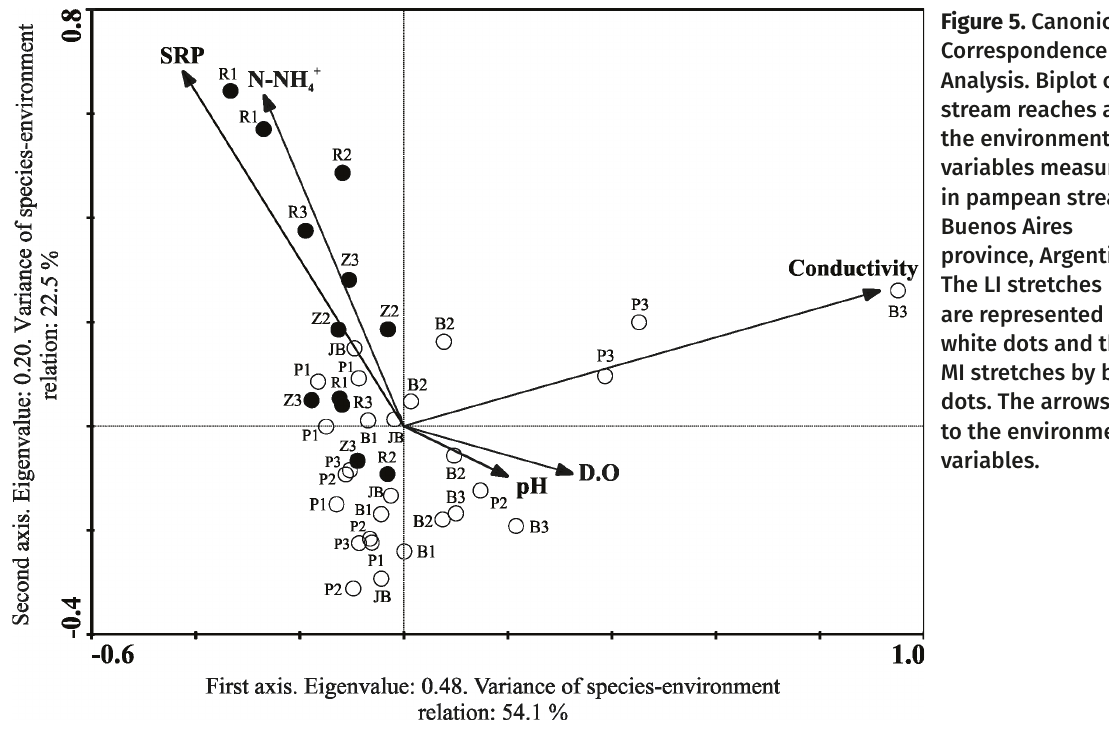
Correspondence Analysis. Biplot of stream reaches and the environmental variables measured